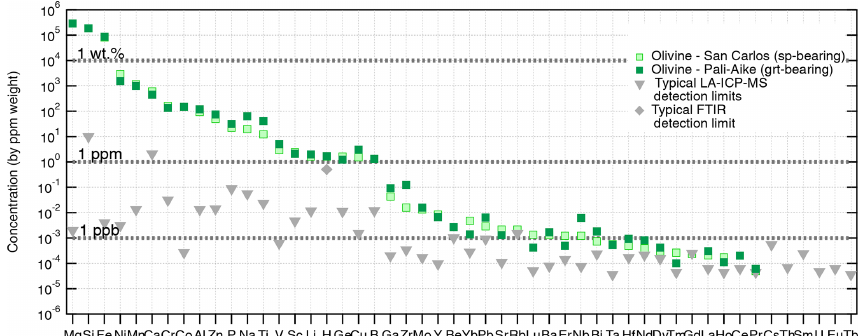
Figure 4. Atomic impurities in San Carlos olivine (spinel-bearing peridotite) ranked by decreasing concentration (ppm), and in a Pali-Aike olivine (garnet-bearing peridotite) for comparison. Typical LA-ICP-MS detection limits are indicated by grey triangles, and the typical unpolarized FTIR detection limit for H by the grey diamond. Analytical details, the original dataset, and further comparison with olivines from other geological settings are available in Demouchy and Alard